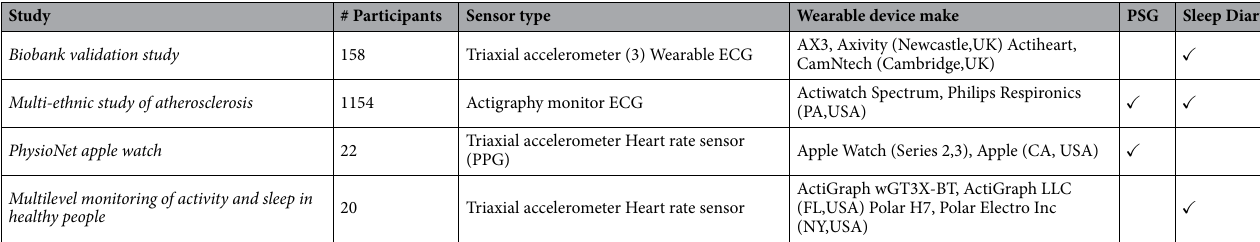
Table 1. Summary of population size and devices used in the different